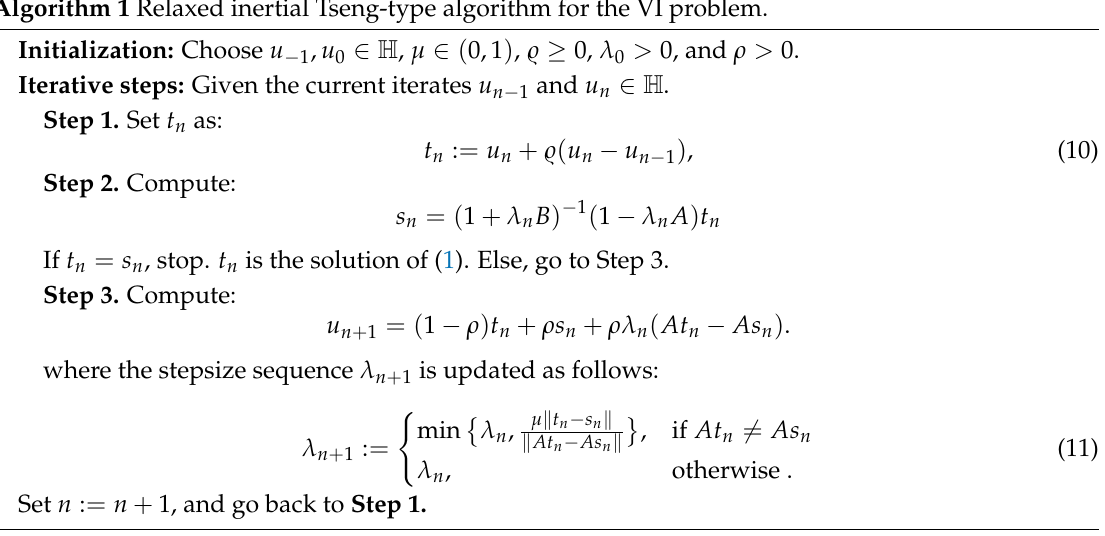
Algorithm 1 Relaxed inertial Tseng-type algorithm for the VI